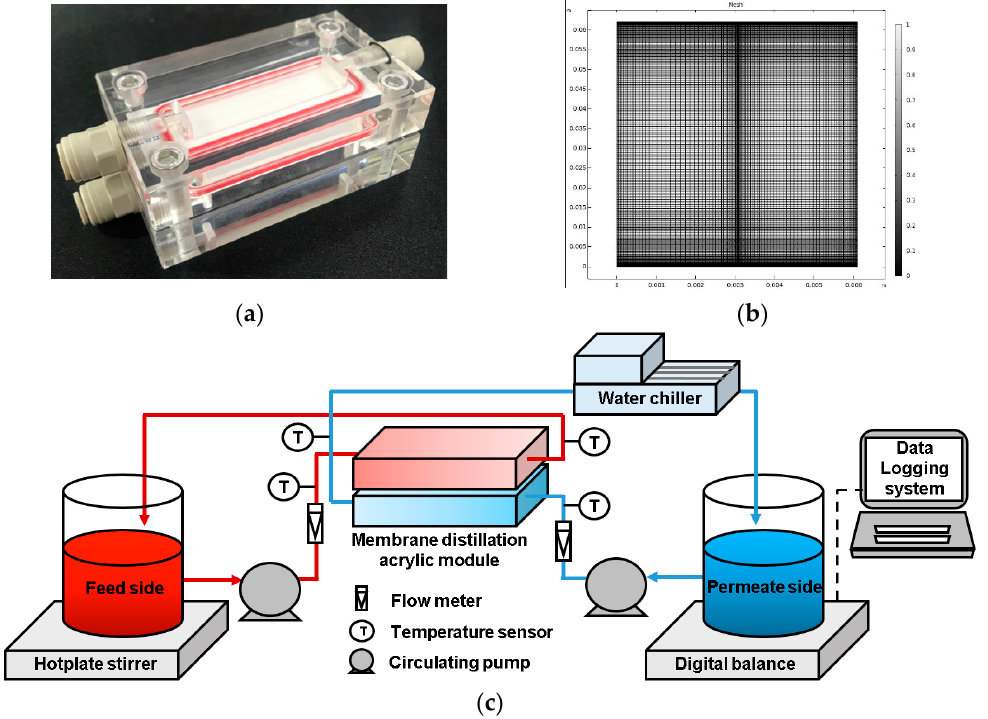
Figure 2. ( a ) Acrylic DCMD module, ( b ) model geometry and meshes used for the CFD simulation, and ( c ) schematic diagram of lab-scale experimental setup Table 1. Summary of CFD model parameters.